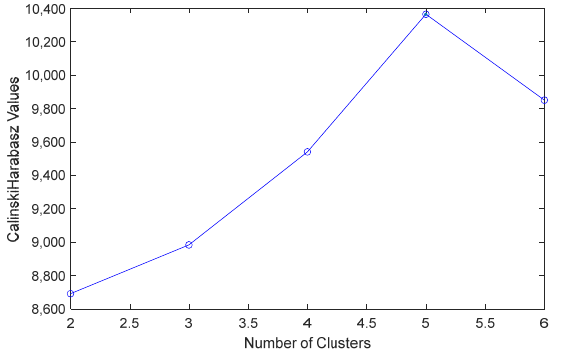
Figure 8. Data Figure 9. Clustering optimization using Calinski-Harabasz index.